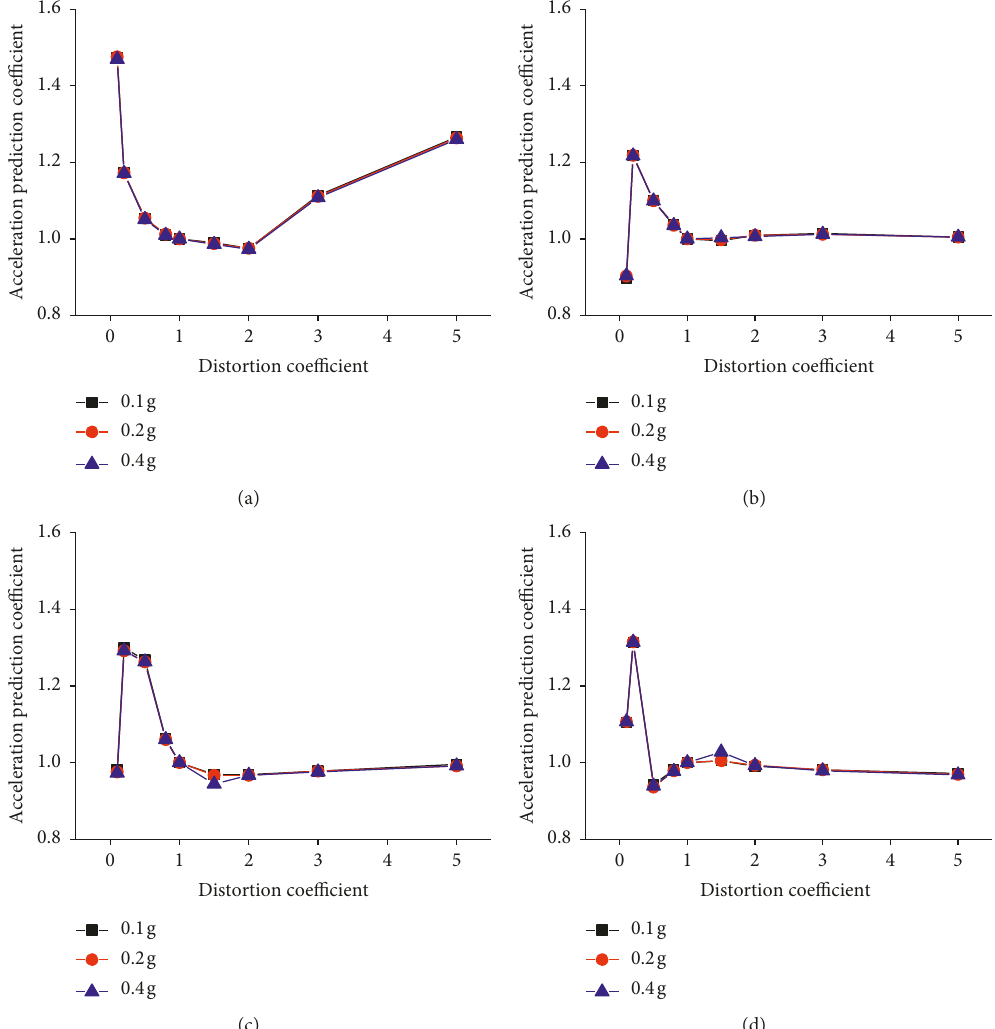
Figure 5: Acceleration prediction coefficient results under different distortion coefficients with different acceleration peaks. (a) EL Centro. (b) Taft. (c) Northridge. (d)